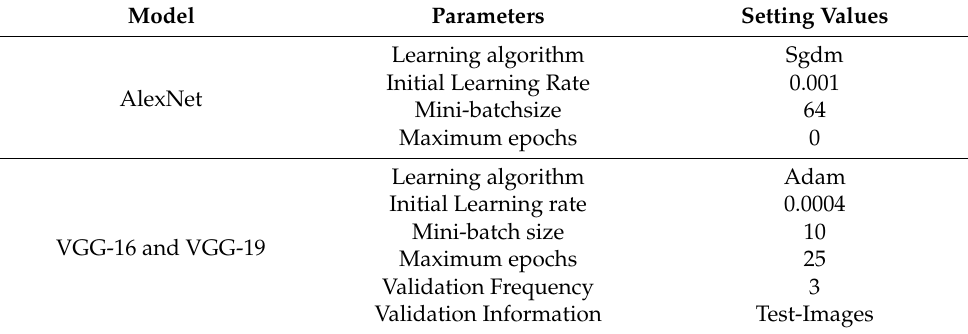
Table 4. Experimental training parameters for AlexNet, VGG-16 and VGG-19.